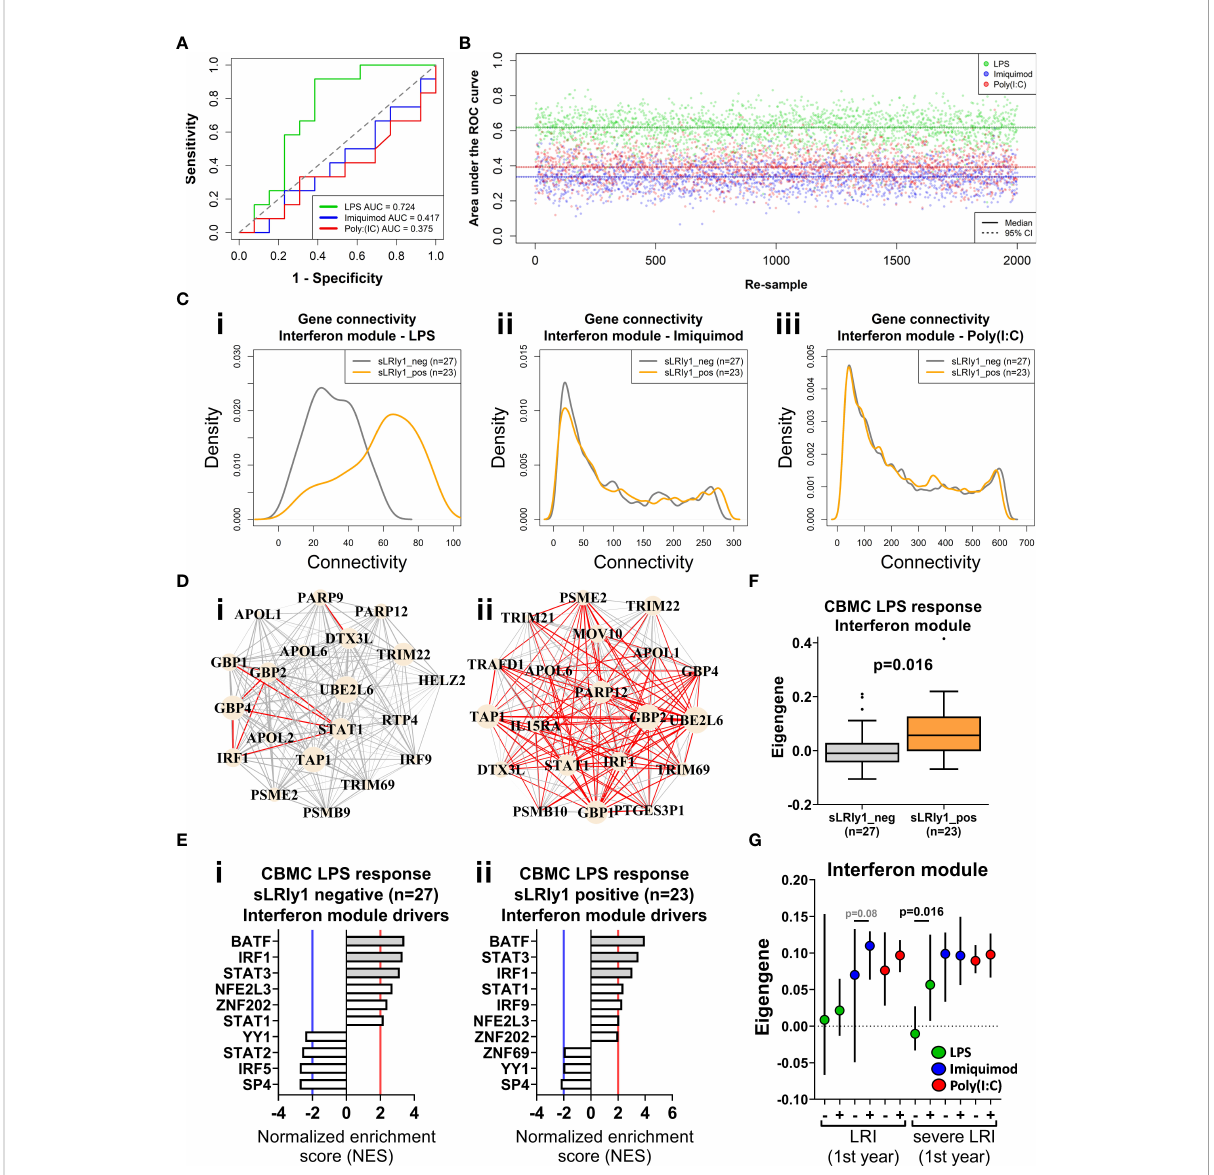
FIGURE 4 IFN genes activated following LPS stimulation at birth predict sLRI susceptibility in the fi rst year of life. (A) Random forest (RF) classi fi ers were trained on the respective IFN module genes from half the study subjects and validated on the remaining subjects (50/50). RF models were optimised with respect to number of genes sampled at each split and number of trees grown. Plot depicts the area under the Receiver Operator Characteristic curve (AUC-ROC) de fi ned by the rate of false (x-axis, 1-speci fi city) and true (y-axis, sensitivity) positives. (B) RF model predictions were repeated by re-sampling the training/validation set (50/50 random assignment) 2,000 times. Plot show the AUC-ROC for each re-sample, with median (solid lines) and 95% CIs (dashed lines). (C) Network connectivity density plot of IFN module gene networks strati fi ed by individuals who did (orange) and did not (grey) record an sLRI in the fi rst year of life. (D) Network wiring diagram of the most connected genes of the CBMC LPS-induced IFN module gene from individuals resistant (I, n=27) and susceptible (II n=23) to sLRIs in infancy. Node and edge characteristics are the same as Figure 3B. (E) Top 10 master regulators identi fi ed for the CBMC LPS-induced IFN response module for resistant (i) and susceptible (ii) subjects. Bar plot characteristics are the same Figure 3C. (F) Box-and-whisker plot of the CBMC LPS-induced IFN module eigengene, grouped by susceptible (orange) and resistant (grey) individuals. Boxes show median, 25 th and 75 th quartiles and whiskers are determined by the Tukey method; P value determined by Mann-Whitney U test. (G) Plot of IFN module eigengenes for CBMC responses grouped by individuals who were resistant (-) and susceptible (+) to LRIs and sLRIs in infancy. P values determined by Mann-Whitney U test and signi fi cant result re fl ects (F) . Plot shows median (symbol) and 95% CI